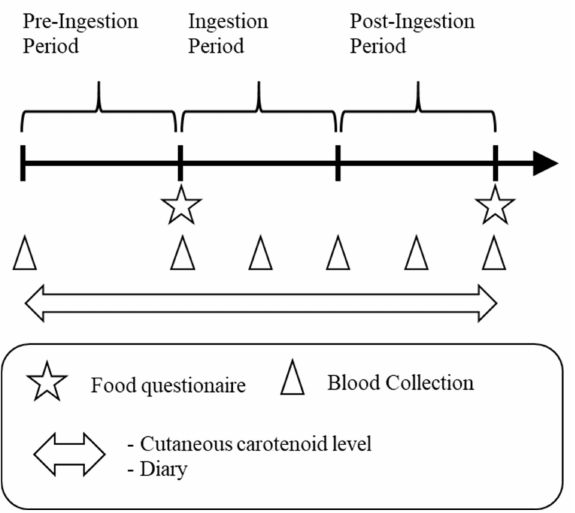
Figure 1. Study schedule. Each period was 4